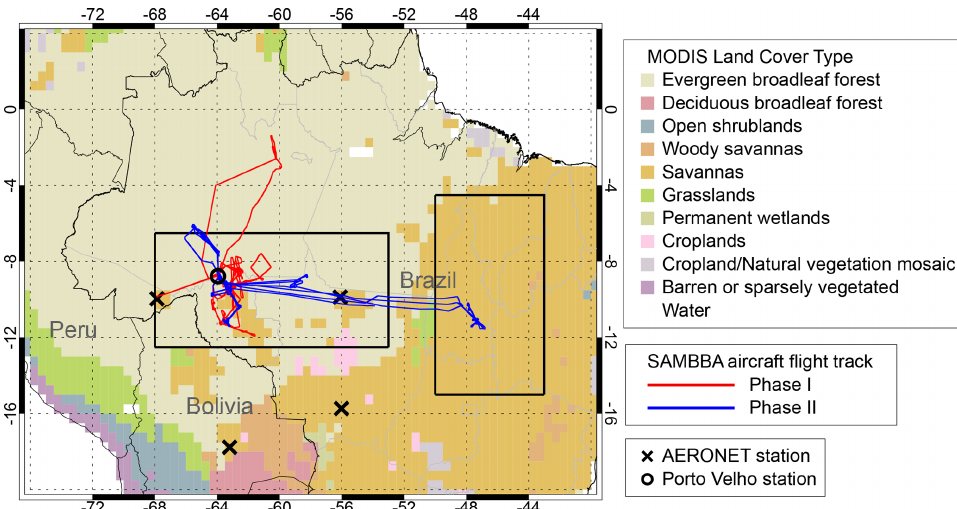
Figure 2. Flight tracks of the FAAM aircraft during the SAMBBA field campaign (Phase 1: 13–23 September; Phase 2: 23 September– 3 October 2012). The location of the Porto Velho ground station is shown by a black circle. The locations of AERONET stations operating during the SAMBBA campaign are shown by black crosses: Porto Velho UNIR (8.84 ◦ S, 63.94 ◦ W), Alta Floresta (9.87 ◦ S, 56.10 ◦ W), Rio Branco (9.96 ◦ S, 67.87 ◦ W), Cuiabá-Miranda (15.73 ◦ S, 56.02 ◦ W) and Santa Cruz UTEPSA (17.77 ◦ S, 63.20 ◦ W). The eastern (4.5–15 ◦ S, 43–50 ◦ W) and western (6–12 ◦ S, 54–68.5 ◦ W) domains are shown with black boxes. Land cover type is shown using the standard MODIS Land Cover Type Data Product (MCD12Q1) in the IGBP Land Cover Type Classification (Channan et al., 2014; Friedl et al.,